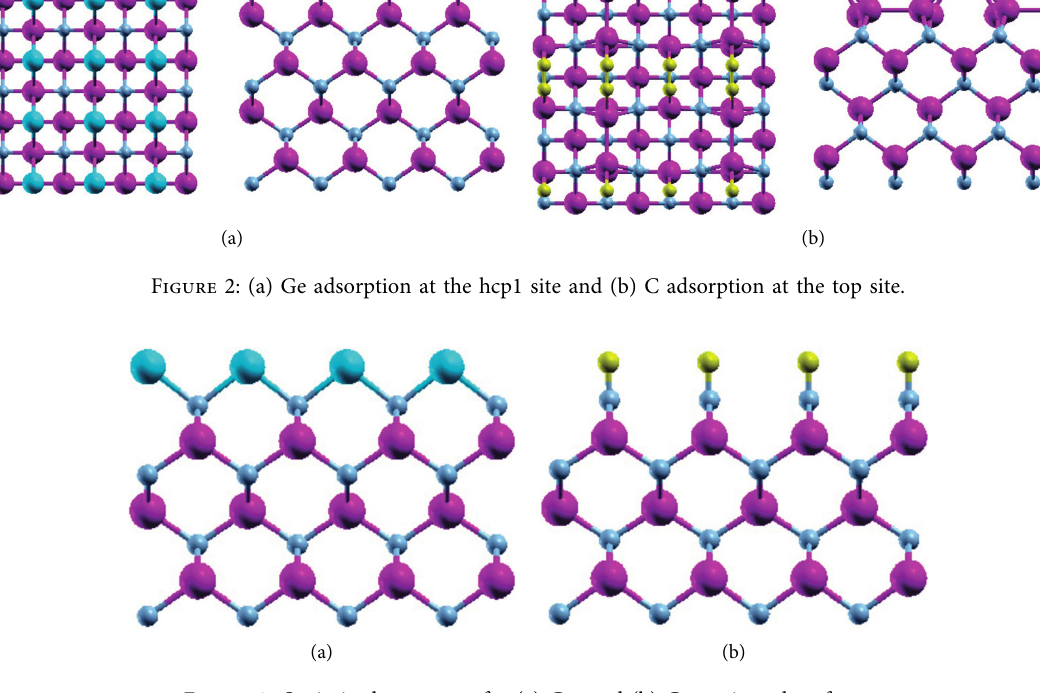
Figure 3: Optimized structures for (a) Ge- and (b) C-terminated